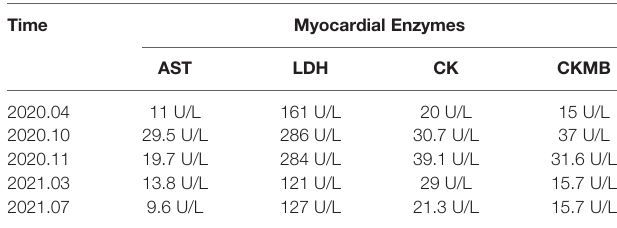
TABLE 2 | The changes in myocardial enzymes at cardiac failure and during recovery treatment. Time